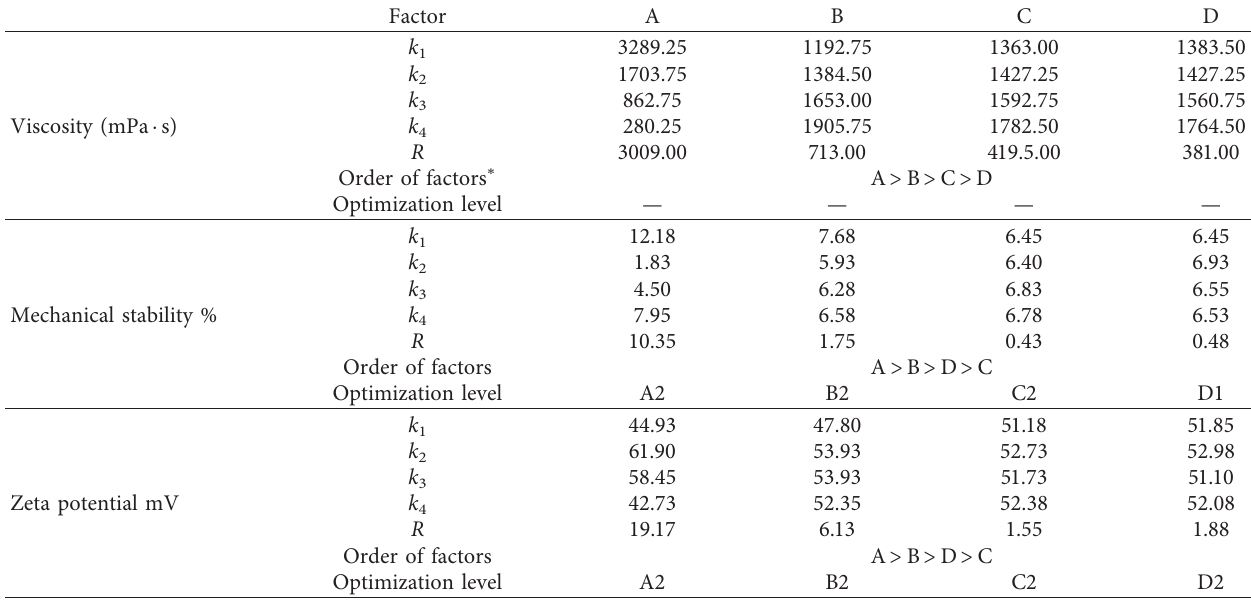
Table 4: Range analysis on the viscosity, mechanical stability, and zeta potential of SBS latex.